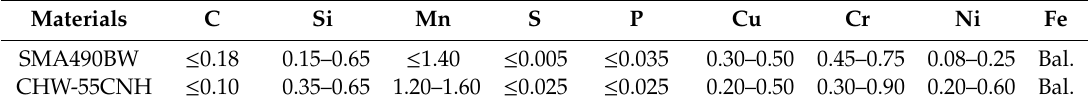
Table 1. Chemical composition of experimental materials (wt %).